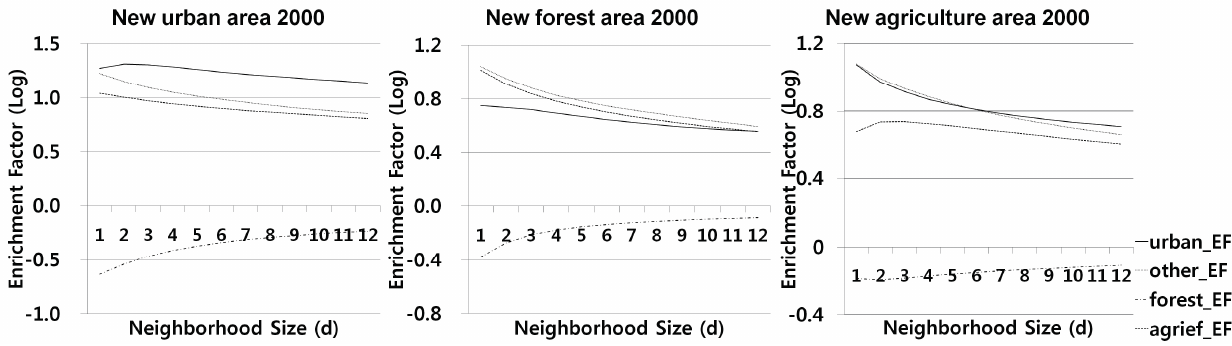
Figure 6. Enrichment factors (EF) of land-use changes between 1990 and